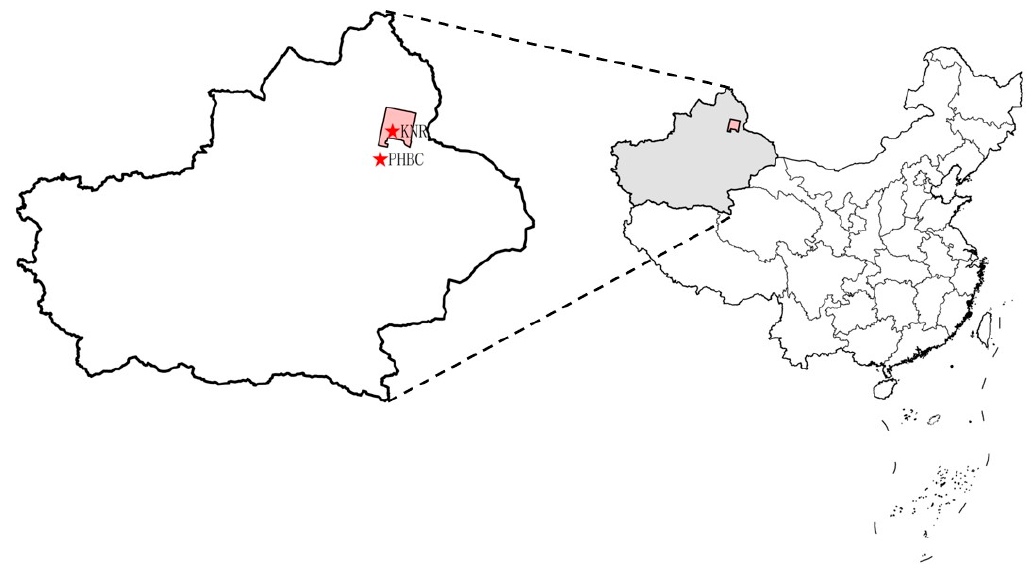
Figure 1. The location of KNR and PHBC. The figure was generated by Google Maps.